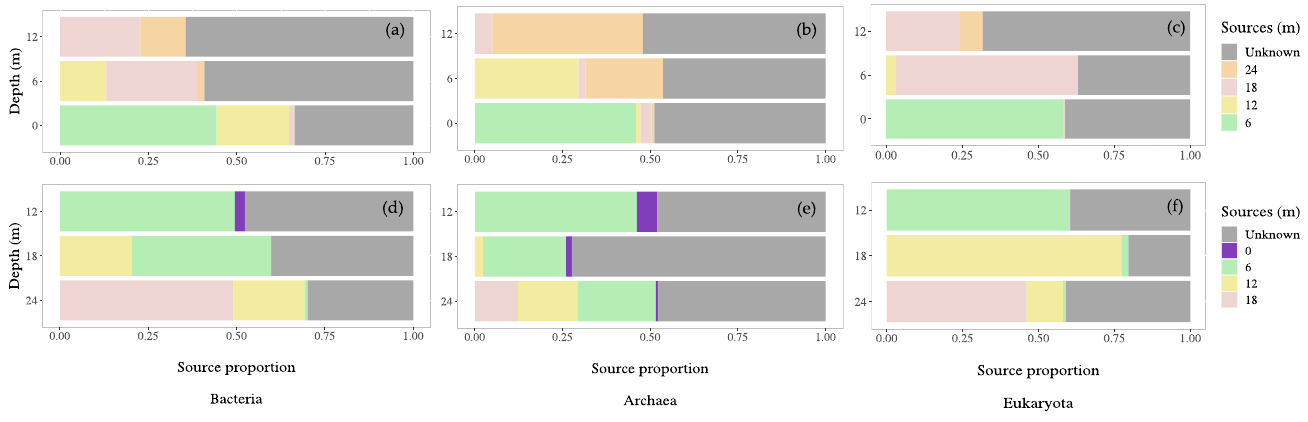
Figure 5. Microbial source tracking analyses estimating the contribution of planktonic bacterial ( a ), archaeal ( b ) and eukaryote ( c ) communities from the deeper (12 m) into the surficial layers or bacte- rial ( d ), archaeal ( e ), eukaryoteota ( f ) from surficial (12 m) into the deeper layer (24 m) communities, across the depth gradient (m). The unknown sources are indicated in grey. Each source correspond to a layer in the depth gradient